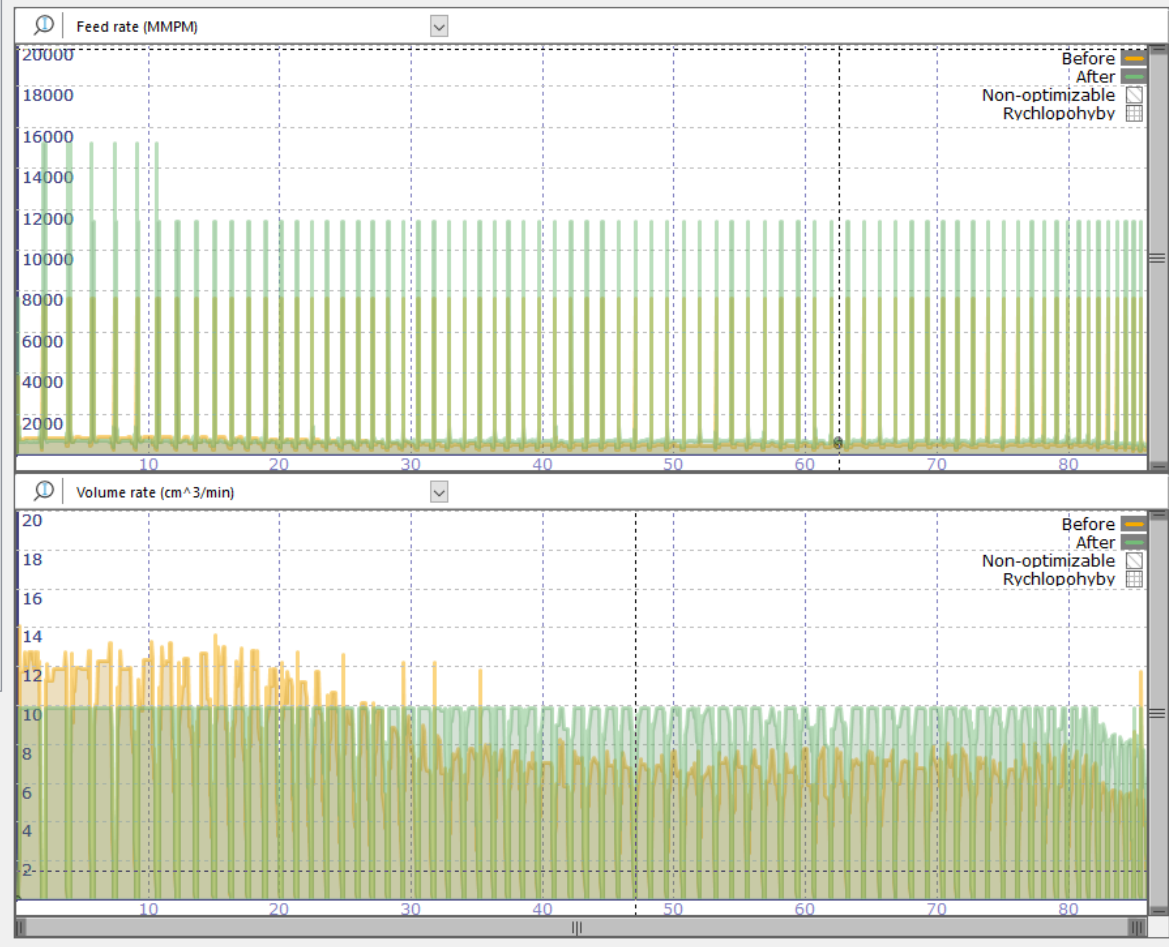
Figure 12. Adjustment of feed rate and material ‐ removal rate values by optimization software.